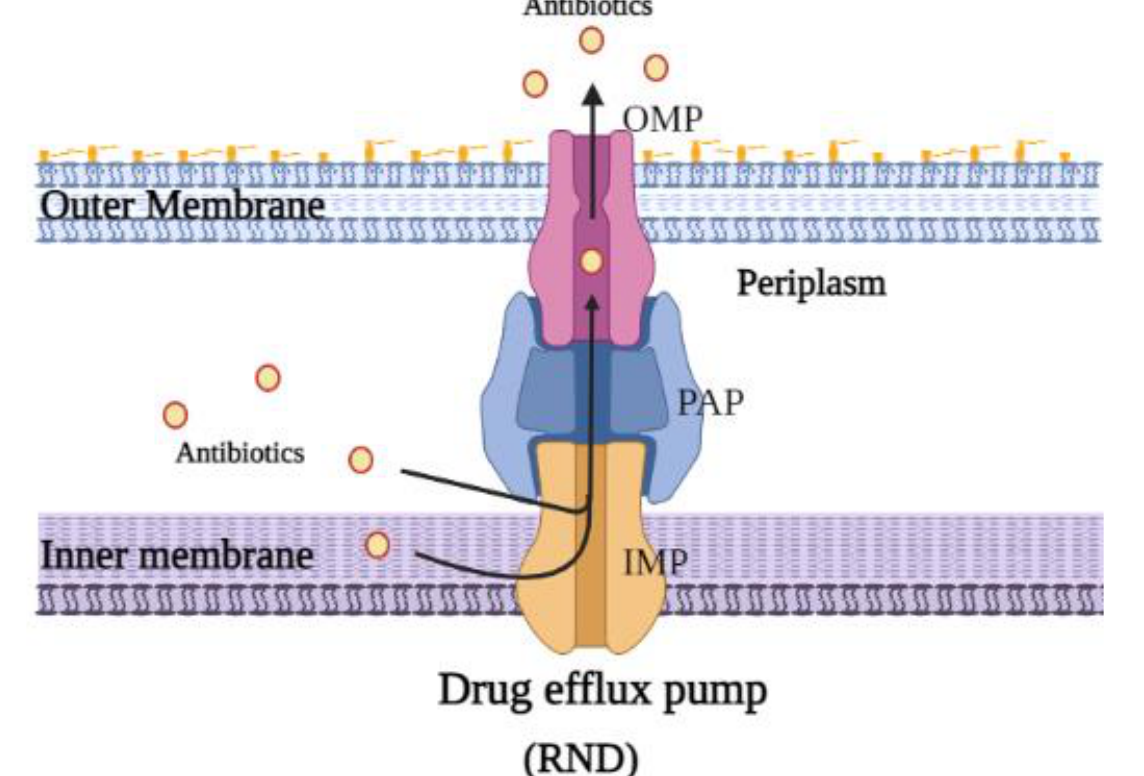
Figure 3. Schematic diagram depicting representative structures of the resistance – nodulation – cell division (RND) family. The RND superfamily are tripartite drug transporters and are formed of three parts; an inner-membrane protein (IMP), an outer-membrane protein (OMP) and a periplasmic adapter protein (PAP), which works as a linker between IMP with OMP.